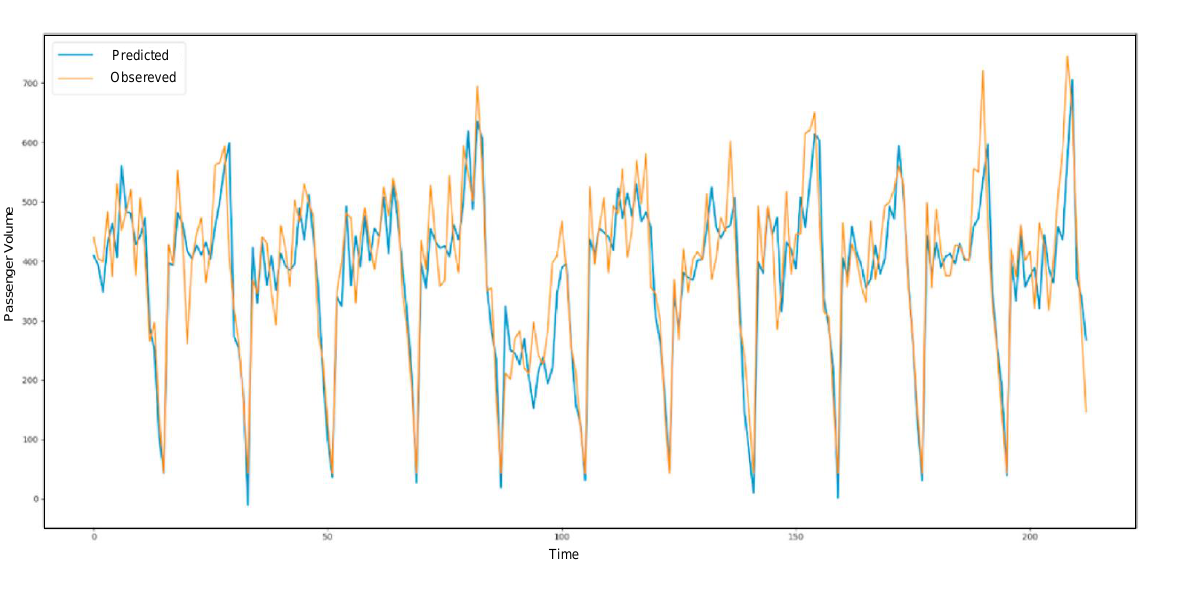
Figure 15. The 60-min prediction result. Table 5. LSTM performance for 15-min